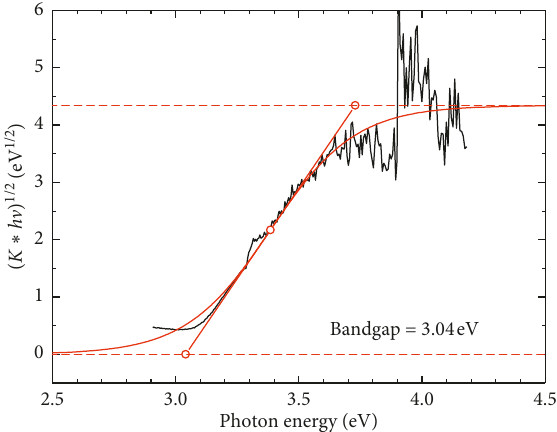
Figure 9: Transformed diffuse reflectance spectrum and de- termination of bandgap